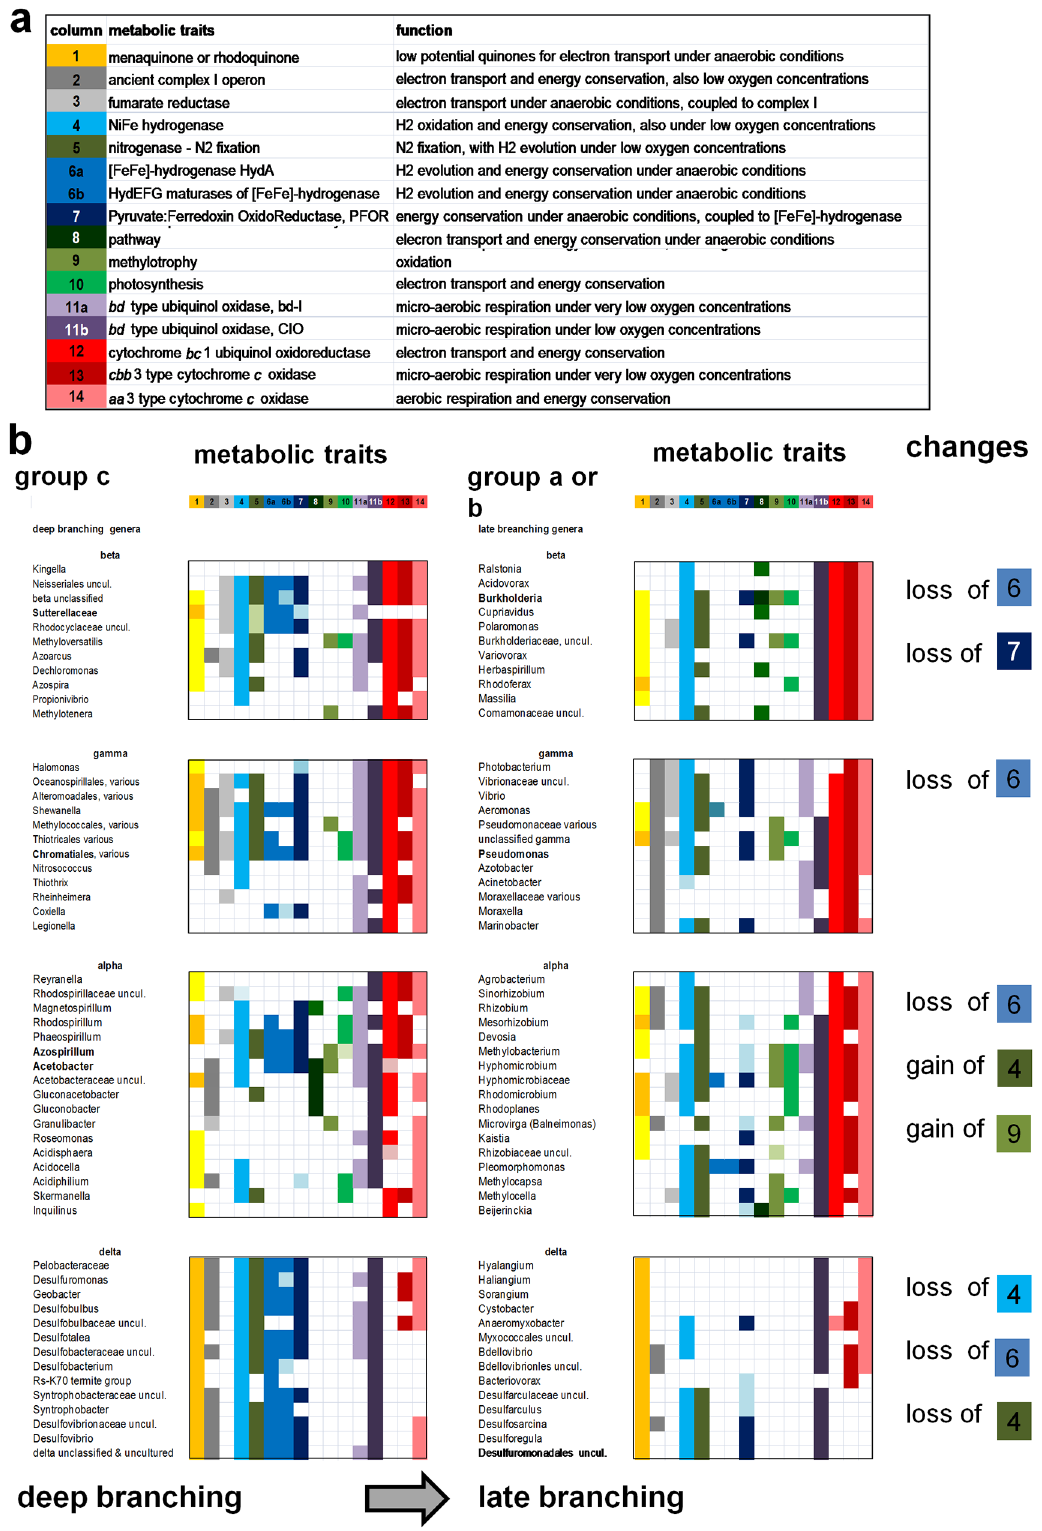
Fig 5. Comparison of discrete functional groups in diverse proteobacterial classeswas rendered along evolutionary trajectoriesfrom late to early diverging taxa in both axes. a. Simplifieddefinitionof the metabolic